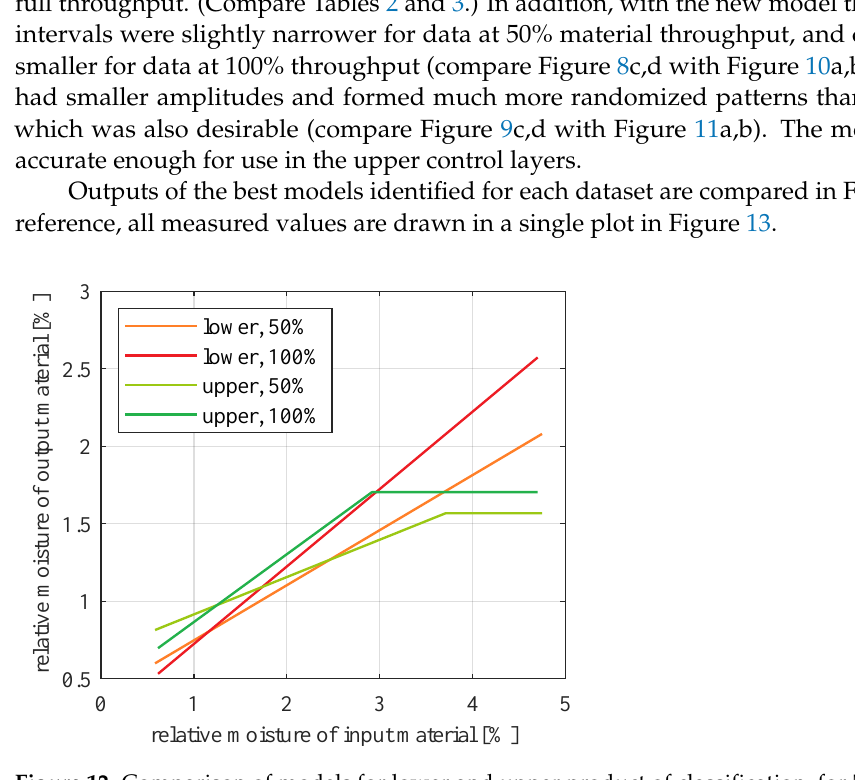
Figure 12. Comparison of models for lower and upper product of classification, for 50% and 100% nominal feeder throughput: straight line models for lower product and saturated straight line models for upper product.